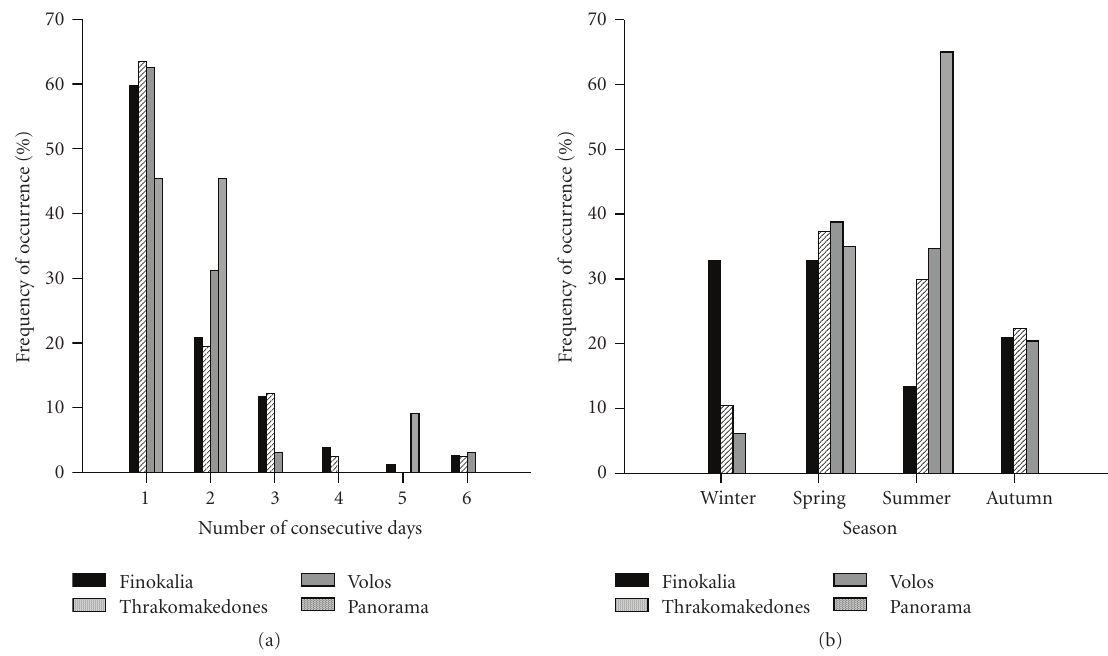
Figure 2: (a) Duration and (b) seasonality of the most significant dust outbreaks according to BSC-DREAM8b.